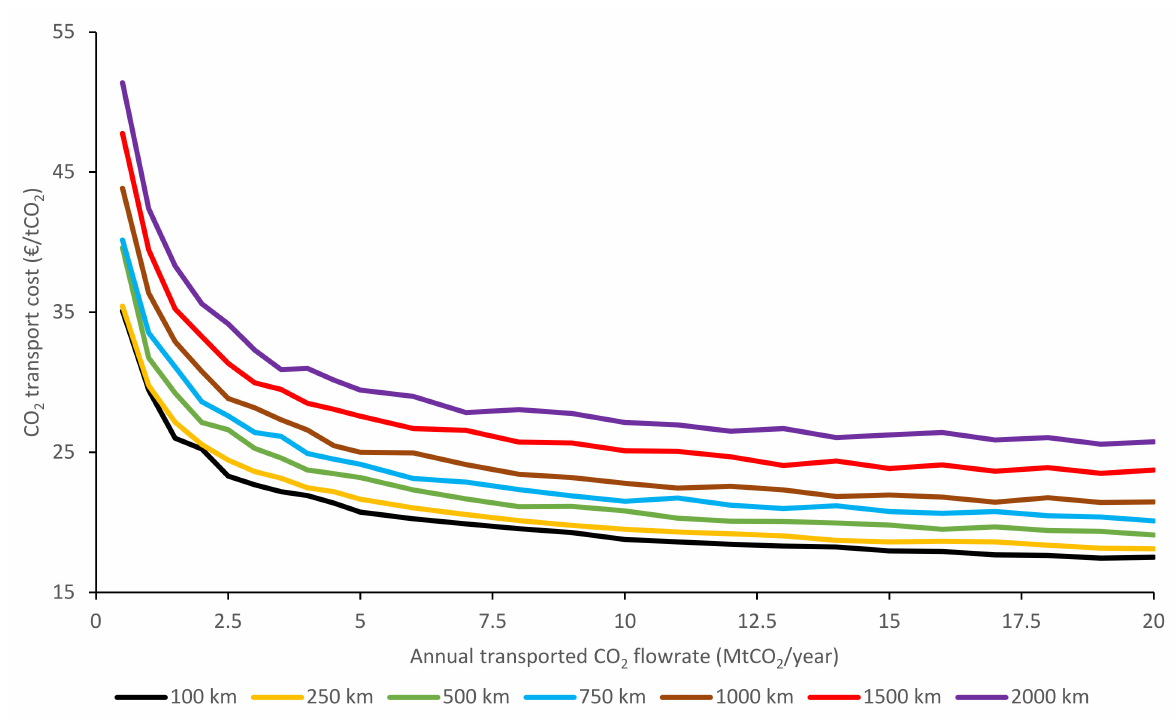
Figure A6. CO 2 conditioning and transport costs as a function of transport distance and annual volume when transporting pure CO 2 to an offshore site by ship at 7 barg.